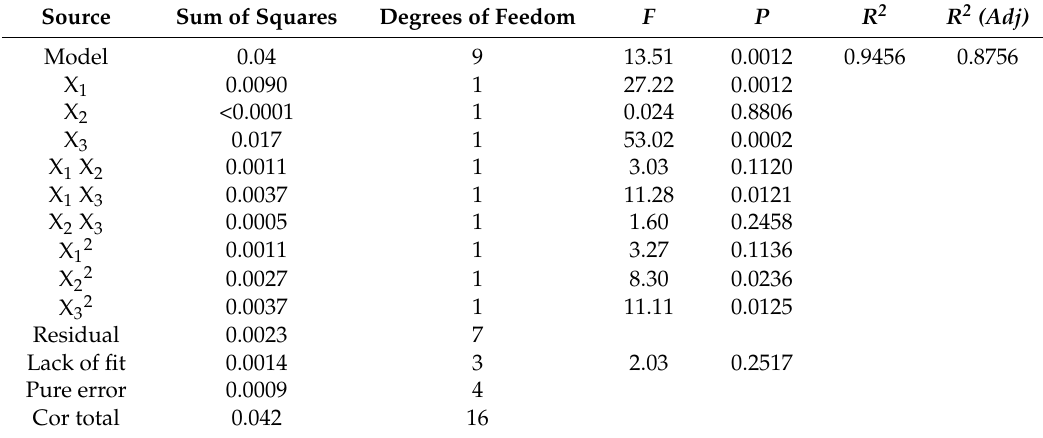
Table 2. ANOVA for the fitted quadratic polynomial model for IC 50 value of antioxidant